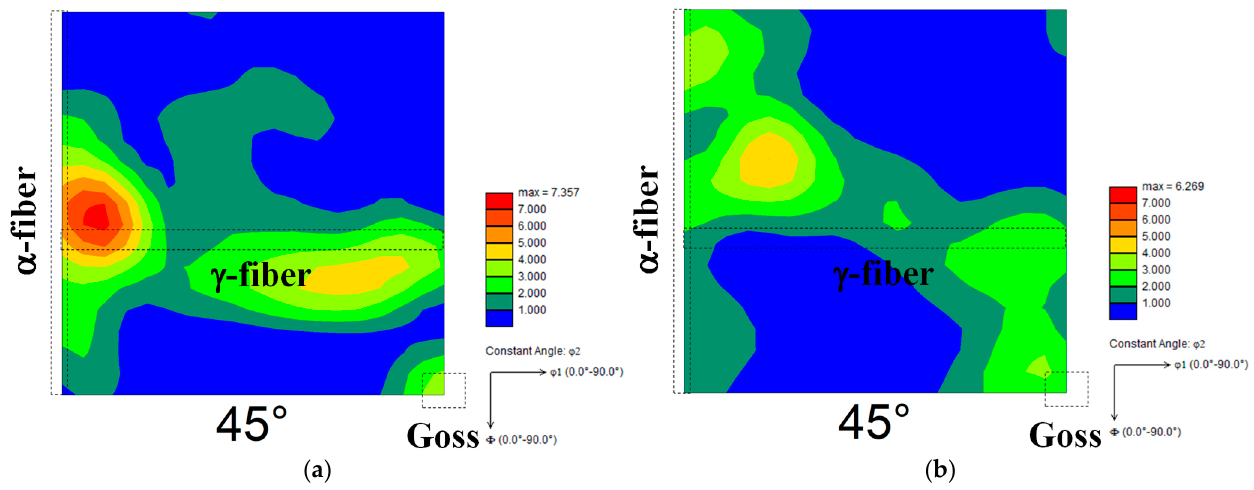
Figure 6. ODF maps of specimens ( a ) A and ( b ) B heated to 1073 K ( φ 2 = 45° section).